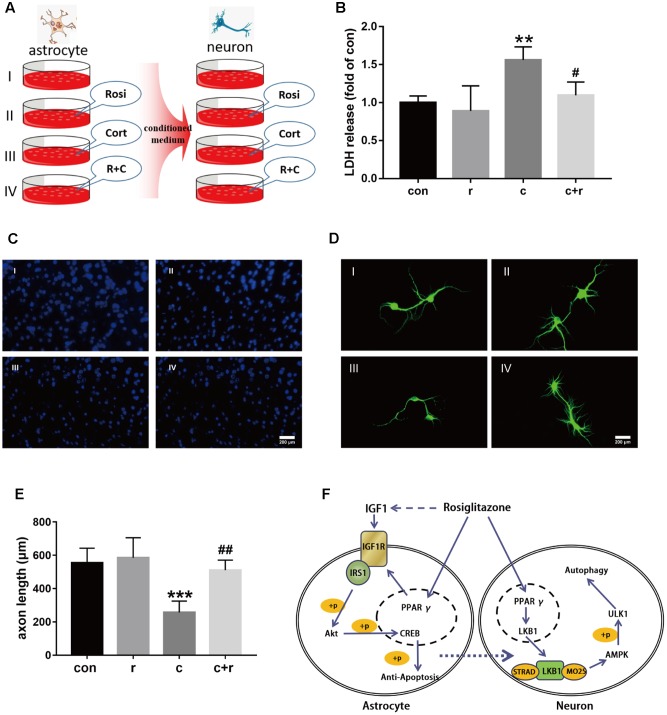
Astrocyte supports neurons by secreting neurotrophic cytokines. (A) Astrocyte conditional medium was collected for culturing neurons. (B) The vitality of neurons exposed to conditional medium and specific concentrations of corticosterone or rosiglitazone was measured by detecting LDH secretion. (C,D) Immunofluorescence-labeled neurons and axons detected by Hoechst and MAP2. (E) The length of axons measured by ImageJ. (I) ACM. (II) ACM + rosiglitazone. (III) ACM + corticosterone. (IV) ACM + corticosterone + rosiglitazone. (F) Summary of the mechanism by which rosiglitazone relieves depression in astrocytes and neurons. Both autophagy and apoptosis ameliorated by rosiglitazone help maintain homeostasis in the mouse prefrontal cortex suffered CMS stimulation via specific pathway. Data are presented as means ± SEMs; n = 4 for LDH assay. ∗p < 0.05 vs. control, ∗∗∗p < 0.001 vs. control, ###p < 0.01 vs. corticosterone. cort, corticosterone; rosi, rosiglitazone; c+r, corticosterone + rosiglitazone.